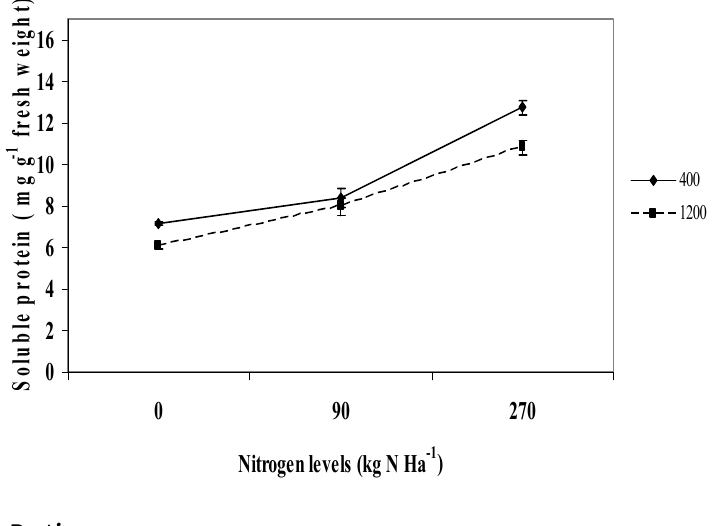
and nitrogen levels on soluble protein content of Figure 5 . Interaction effects between CO 2 L. pumila . N = 12. Bars represent standard error of differences between means (SEM).